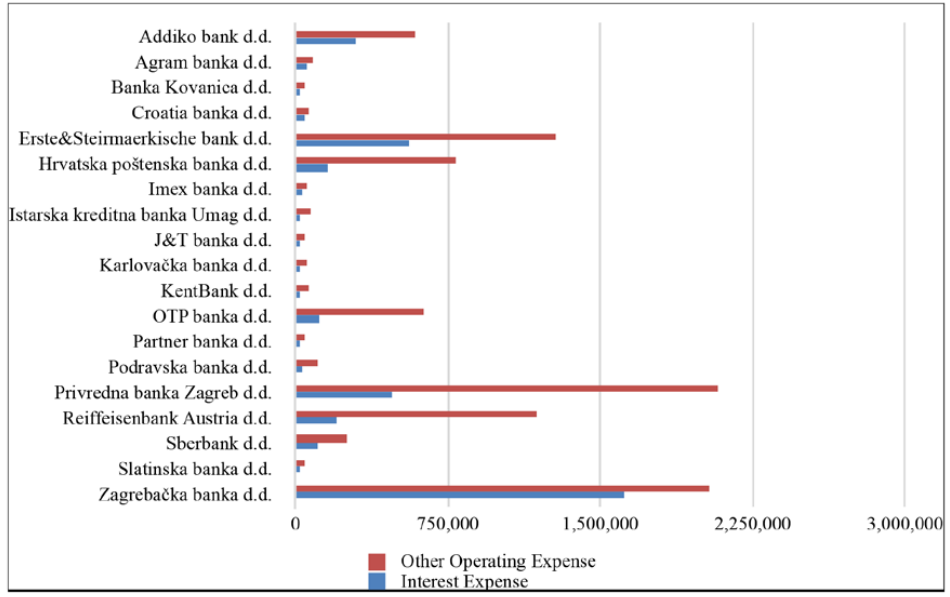
Figure A8. Mean for the inputs for each bank.